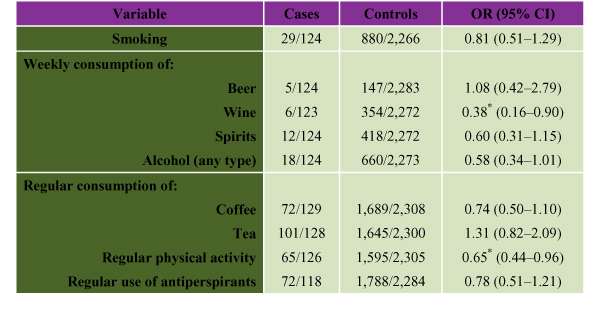
Association of specific lifestyle variables with risk of AD, Canadian Study of Health and Aging, women, 1996